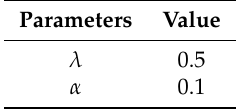
Table 3. Quasi-continuous high order sliding mode (QC-HOSM) gain parameters.